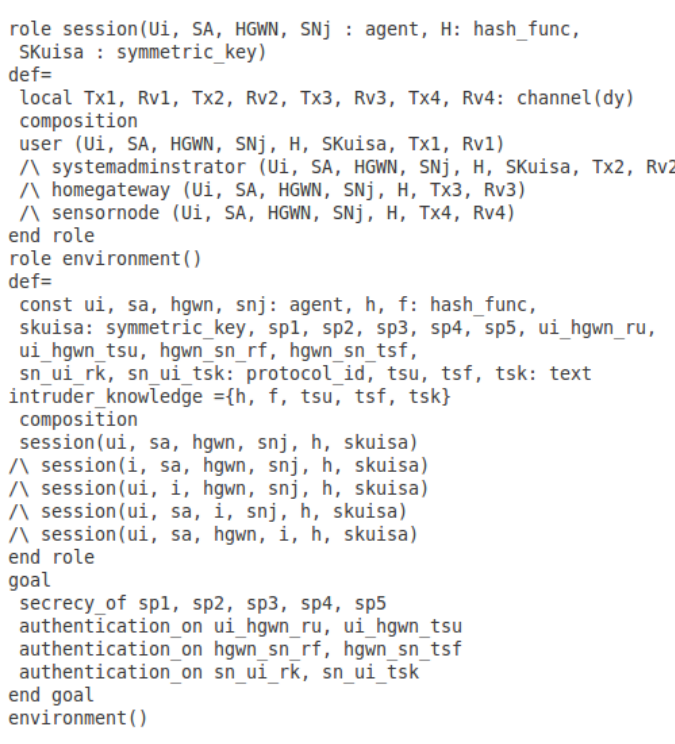
Figure 15. The role session, environment, and goals in